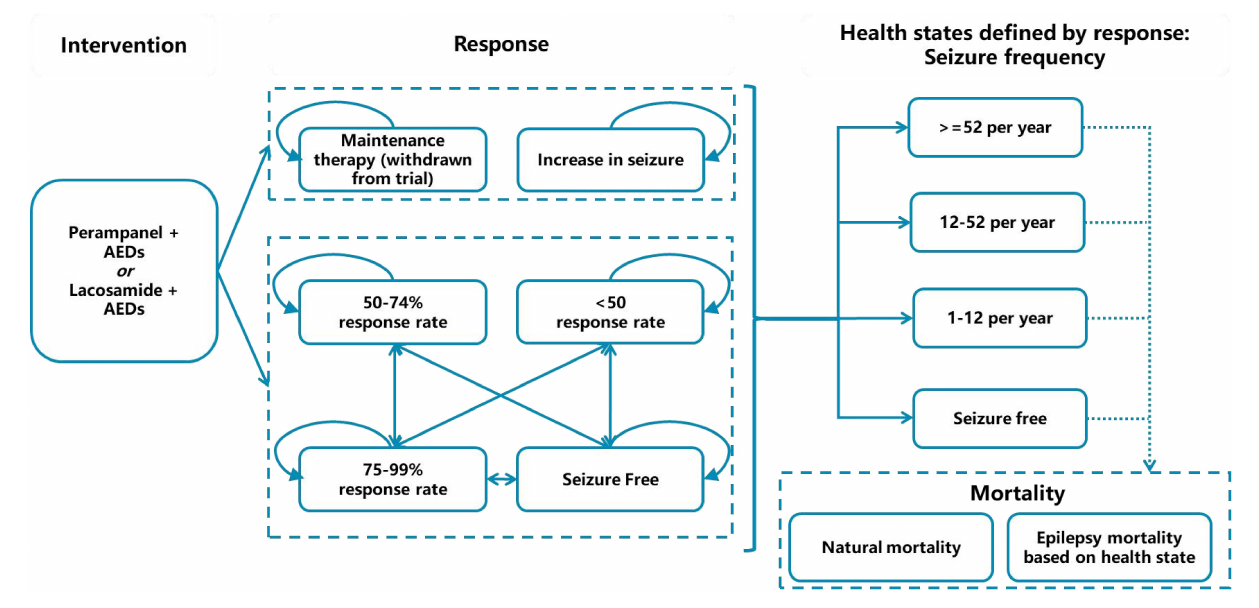
FIGURE 1 | Model structure. AED, antiepileptic drug.